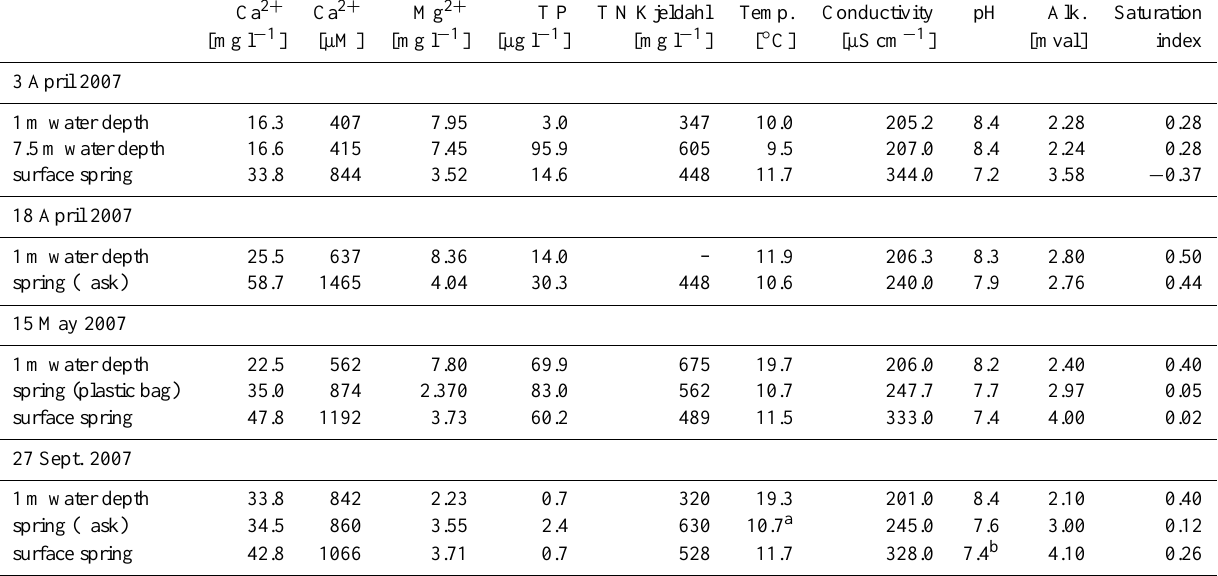
Table 1. Chemical and physical parameters of Kaliˇsta spring waters in April, May and September 2007. The samples were taken at the outlets of surface and subaquatic springs. Barrel, flask and plastic bag indicate different sampling techniques. Lake water samples were taken at different depths above the springs. Saturation indices for carbonate were calculated according to Plummer and Busenberg (1982). Ca 2 + Ca 2 + Mg 2 + T P T N Kjeldahl Temp.